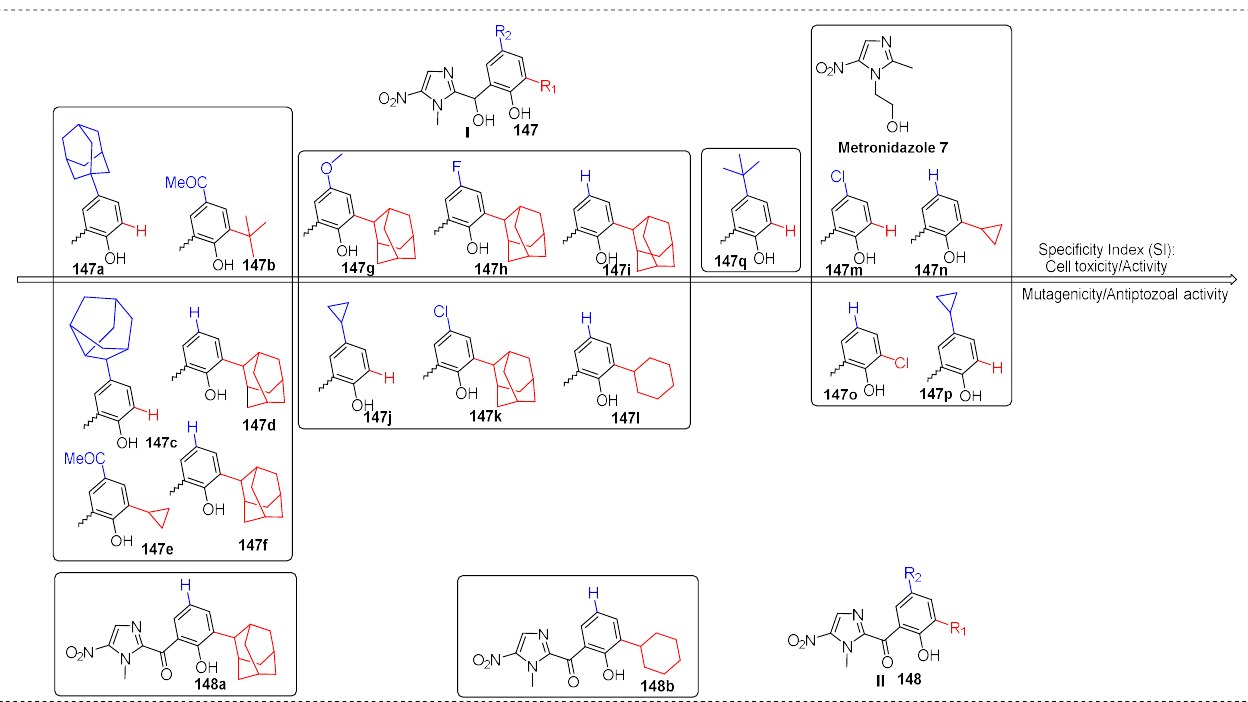
Figure 29. Mutagenic properties of two substituted 5-nitroimidazole derivatives. At a glance, the introduction of a bulky group in R 1 or R 2 decreased the mutations in Salmonella typhimurium.